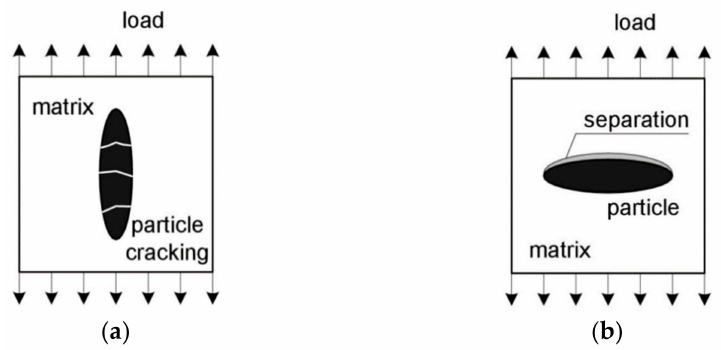
Figure 5. Effect of the orientation of the elongated particle in relation to the loading direction on the void nucleation mechanism: ( a ) the mechanism of fracture of the particle positioned along the loading direction; ( b ) separation of the particle perpendicular to the loading direction, based on